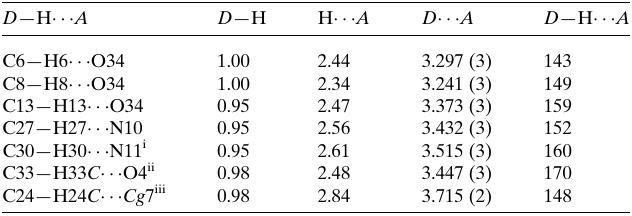
Table 1 Hydrogen-bond geometry (A˚ , (cid:3) ).